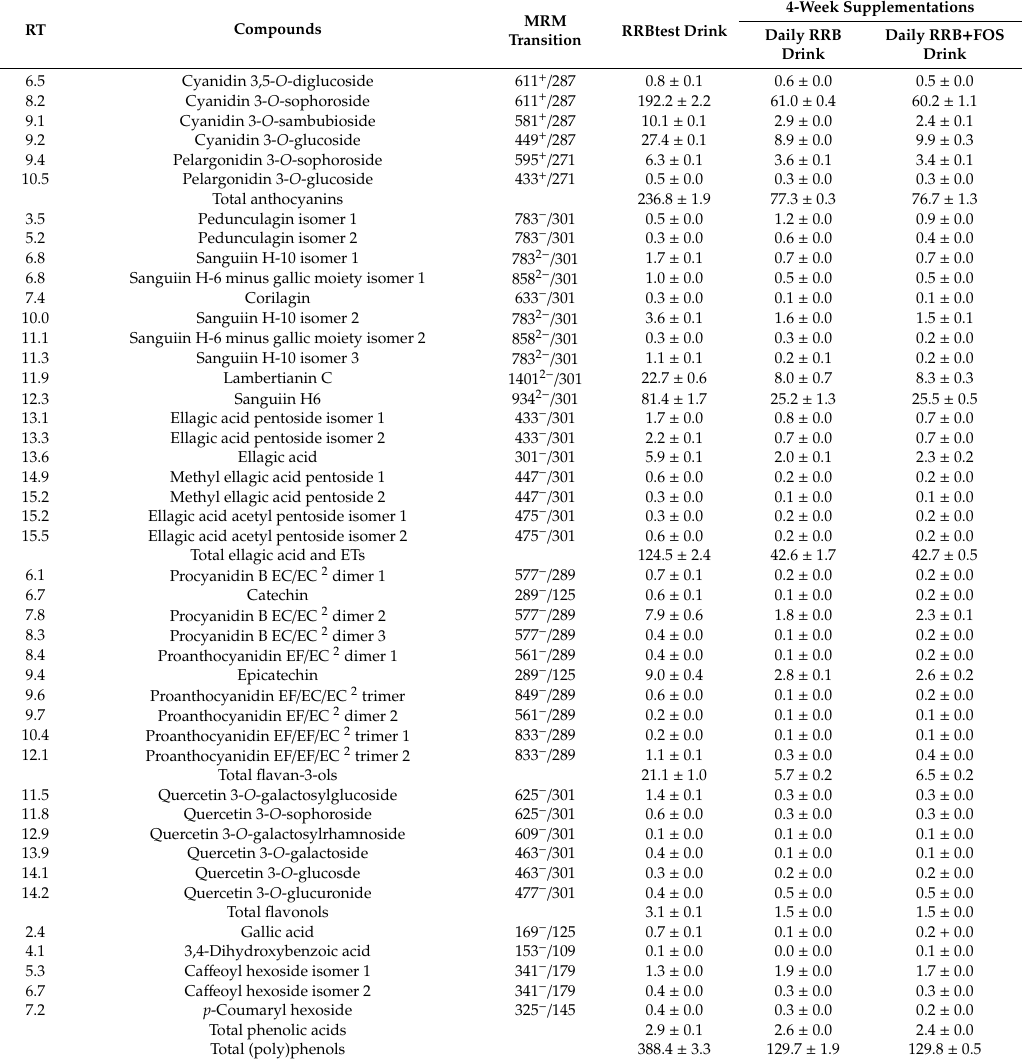
Table 2. Red raspberry (poly)phenol contents in RRB-based test drink (RRBtest) and 4-week supplementations (mg / serving) 1